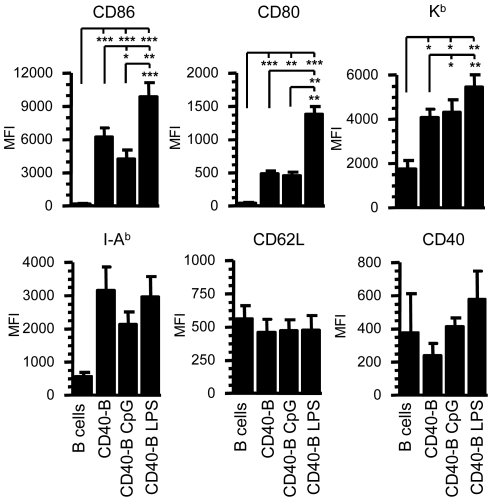
CD40-B cells have an activated phenotype.After 3 d of culture on murine 3T3-CD40L fibroblasts, CD40-B cells were matured or not with LPS (1 µg/mL) or CpG (2 mM) for 24 h (CD40-B LPS and CD40-B CpG). Freshly isolated splenocytes were used as a naïve B cell control. The histogram bars show the mean of fluorescence intensity (MFI) +/− standard deviation of the mean (SEM) for the expression of CD86, CD80, CD62L, CD40, Kb and I-Ab gated on the CD19+ population. The results are pooled from at least three independent experiments except for CD40 expression on B cells (n = 2). * p<0.05, ** p<0.01 and *** p<0.001.